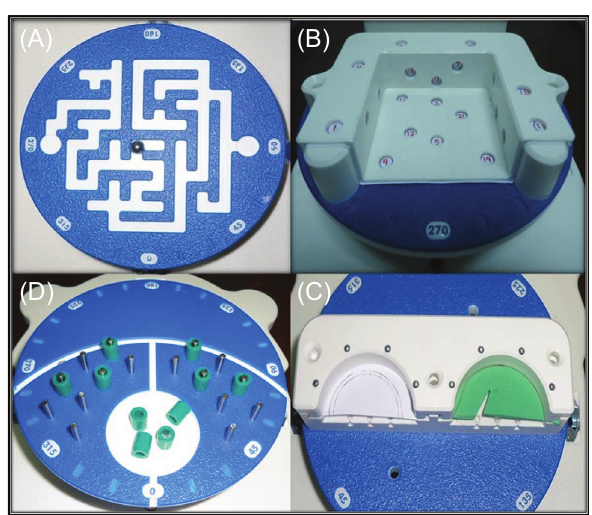
Figure 1. Modules for ‘‘FAST’’ bench workstation. (A) Maze navigation, (B) number probing, (C) object handling-vertical pillars and (D) meniscus